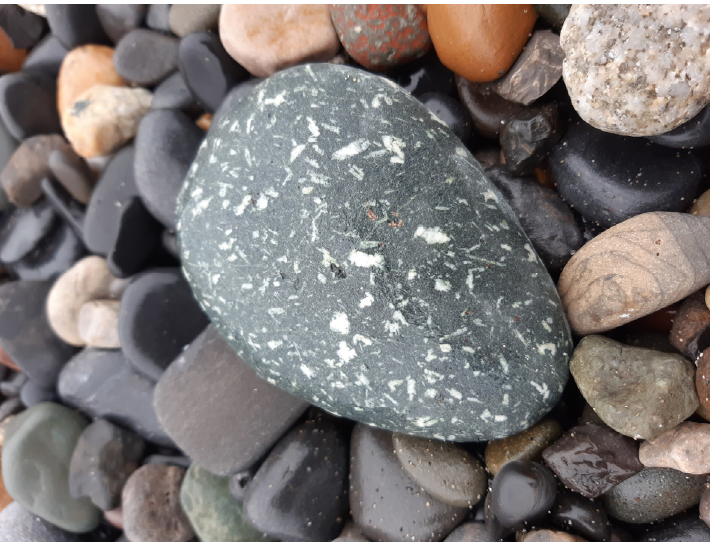
Figure 6. Lambay Porphyry: volcanic pebble common on Killiney beach, County Dublin (Photo: S. Gatley).